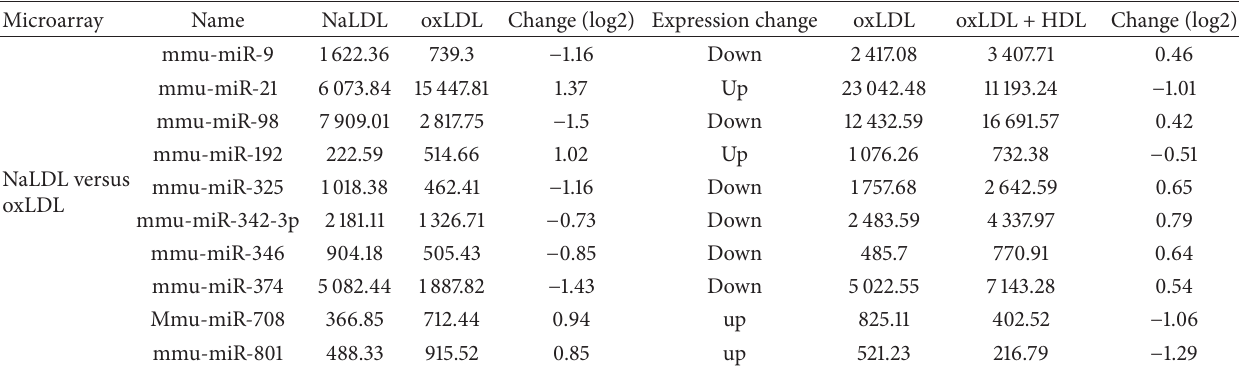
Table 5: Global miRNA profiling of MIN6 cells cultured with human native and oxidized LDL with or without HDL. We compared by microarray analysis the expression of 350 miRNAs in MIN6 cells that were incubated with 2 mmol/L of human native (Na LDL) or oxidized LDL (oxLDL) cholesterol plus or minus 1mmol/L of HDL for 72 hrs.